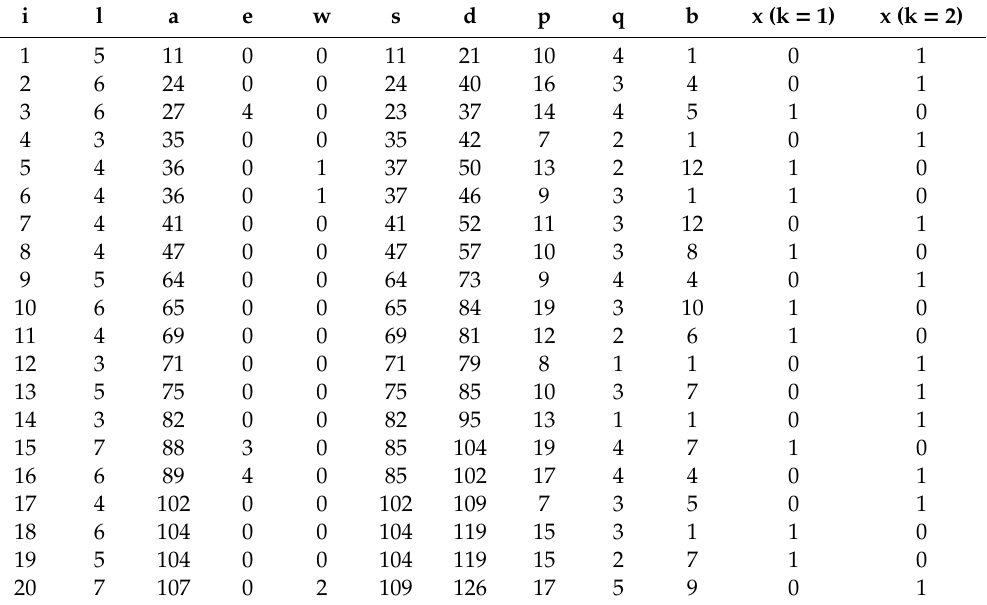
Table A6. Results of the integrated BAP and QCAP solution for Case 11: seed = 400, λ = 3.5, Z (cid:48) = 286.